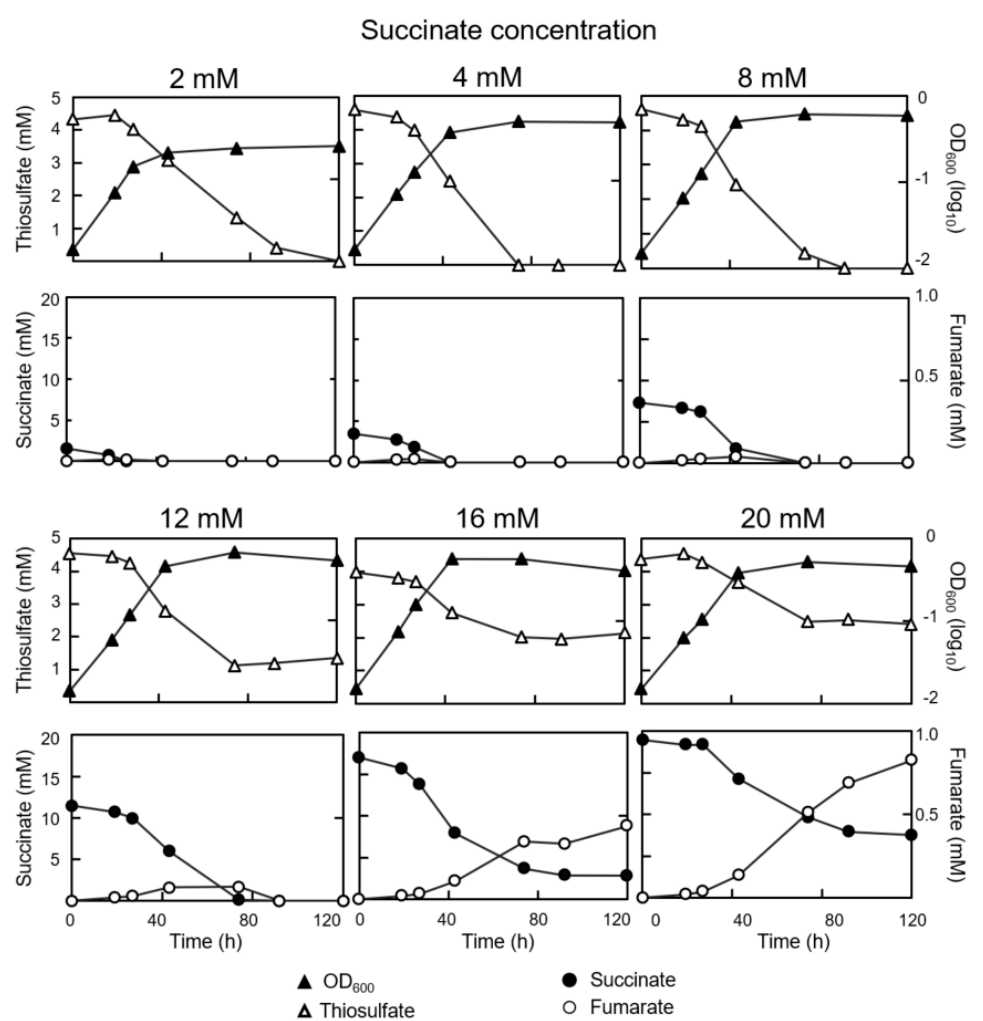
Figure 2. Mixotrophic growth of the B. diazoefficiens wild type. The growth media contained 4 mM thiosulfate and the amounts of succinate indicated above each pair of panels (from 2 to 20 mM). Cell growth was measured as optical density (OD) at A 600 , which is shown in the upper panels together with thiosulfate consumption. Succinate consumption and fumarate production are shown in the lower of panels. Two independent experiments were performed, and one of them is shown.